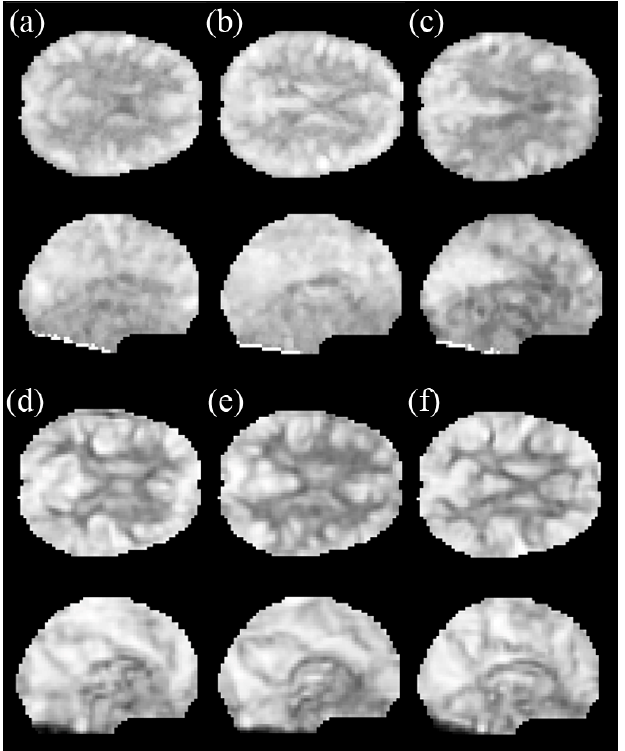
Figure 2. The representative axial and coronal indices of rs-fMRI in the three groups, including the mfALFF map of the ( a ) HC, ( b ) TA, and ( c ) BQ, and the mReHo map of the ( d ) HC, ( e ) TA, and ( f ) BQ. Differences among the HC, TA, and BQ group are virtually impossible to identify directly with human eyes. Thus, we tried to classify three groups using machine learning models. Table 1. Demographic and clinical characteristics. Standard deviations are in parentheses. Betel-Quid Chewers